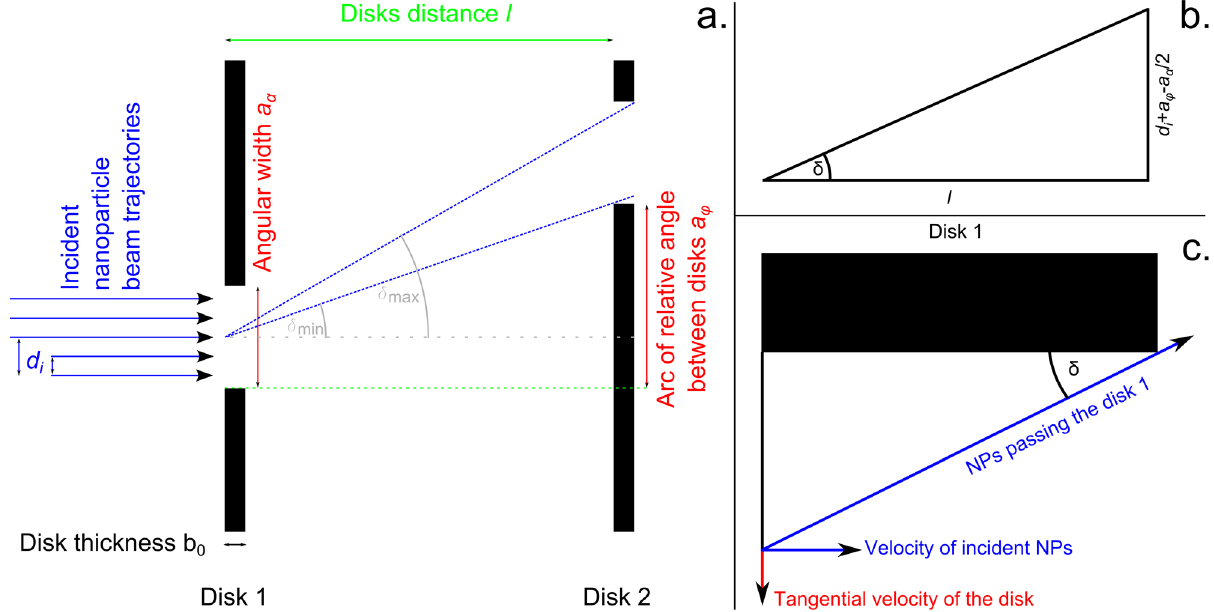
Figure 3. Schematic illustration of the model: ( a ) schematic of the whole system; ( b ) geometric quantities for calculation of δ max or v min ; ( c ) geometric illustration of NPs collected on the inner wall of the entrance slit/ transmitted NPs in the zoomed area around the upper part of the slit in disk